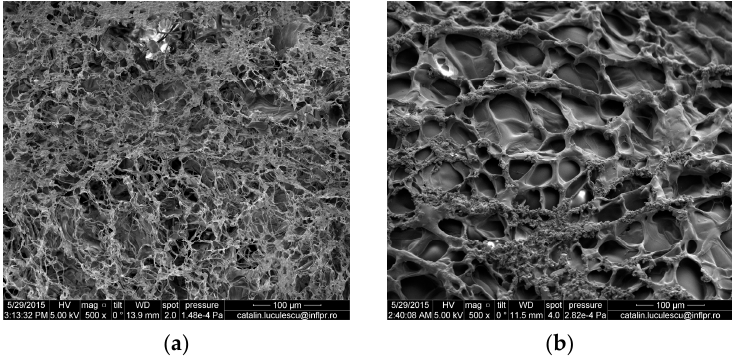
Figure 10. Scanning electron micrographs of hydrogels with 3.70 × 10 − 3 mol/L PP and 2.95 × 10 − 3 mol/L TMPT obtained by electron beam irradiation at ( a ) 2.5 kGy and ( b ) 6.0 kGy.